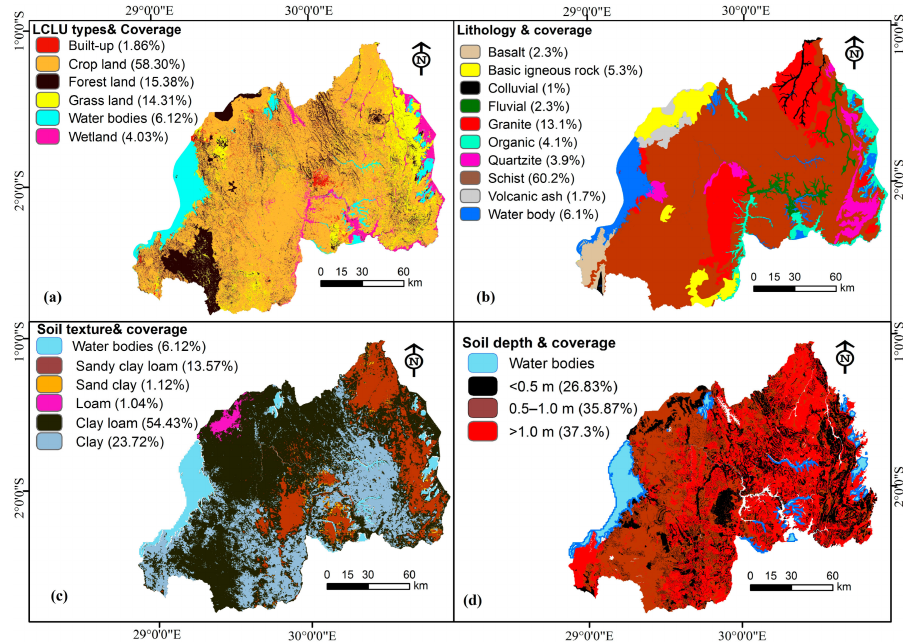
Figure 5. Landslide conditioning factors in the study area: ( a ) Land cover land use types, ( b ) Lithology, ( c ) Soil texture, ( d ) Soil